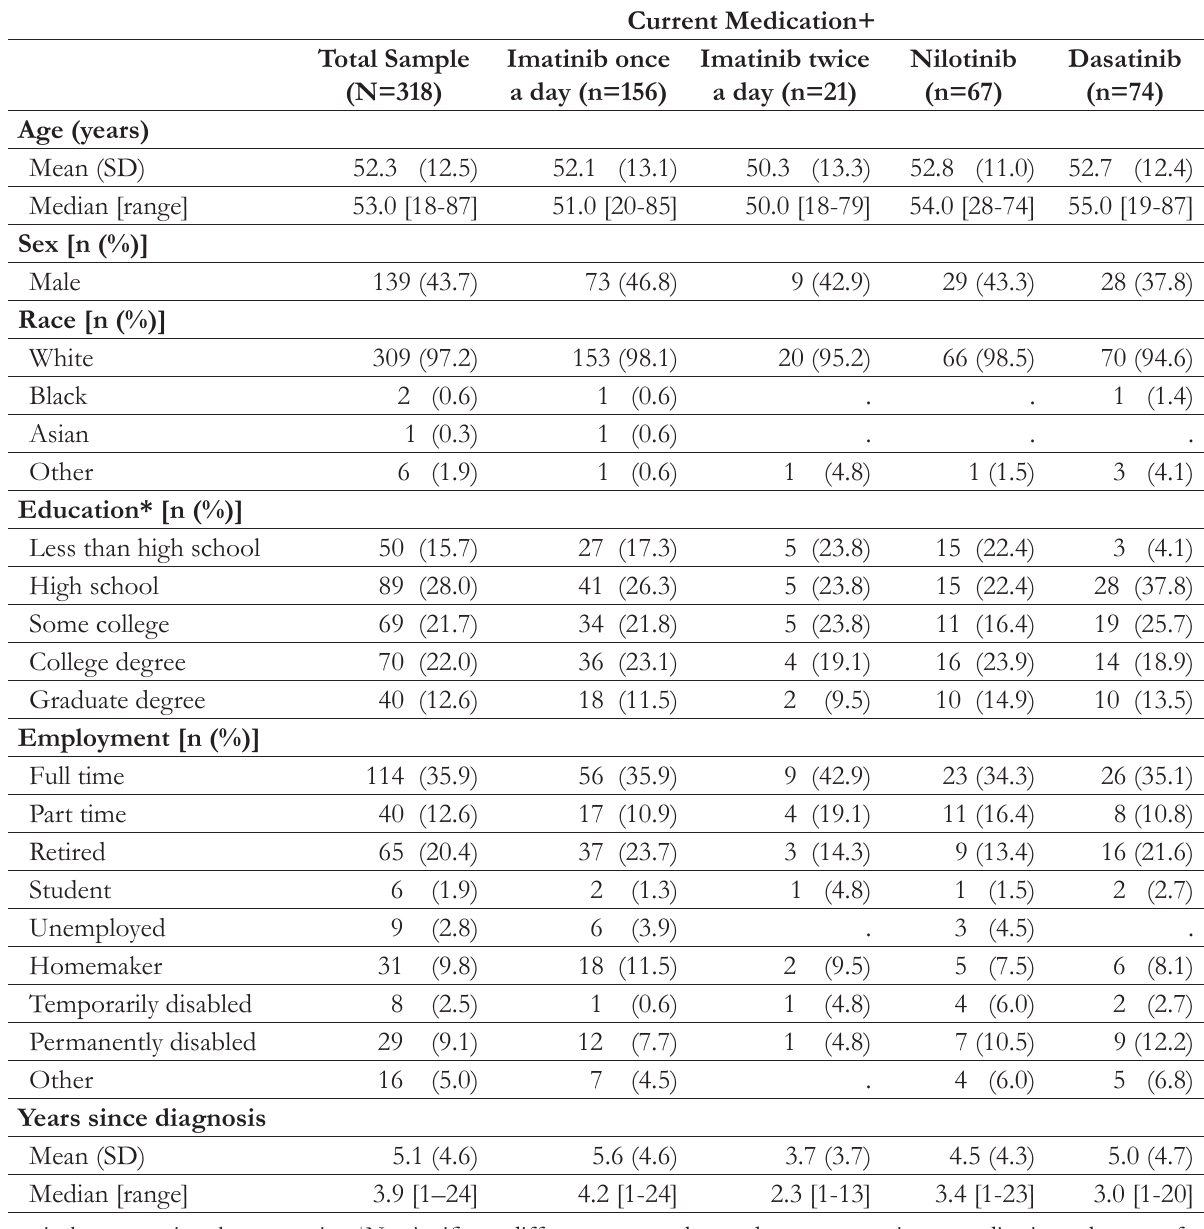
Table 1. Socio-demographic and Clinical